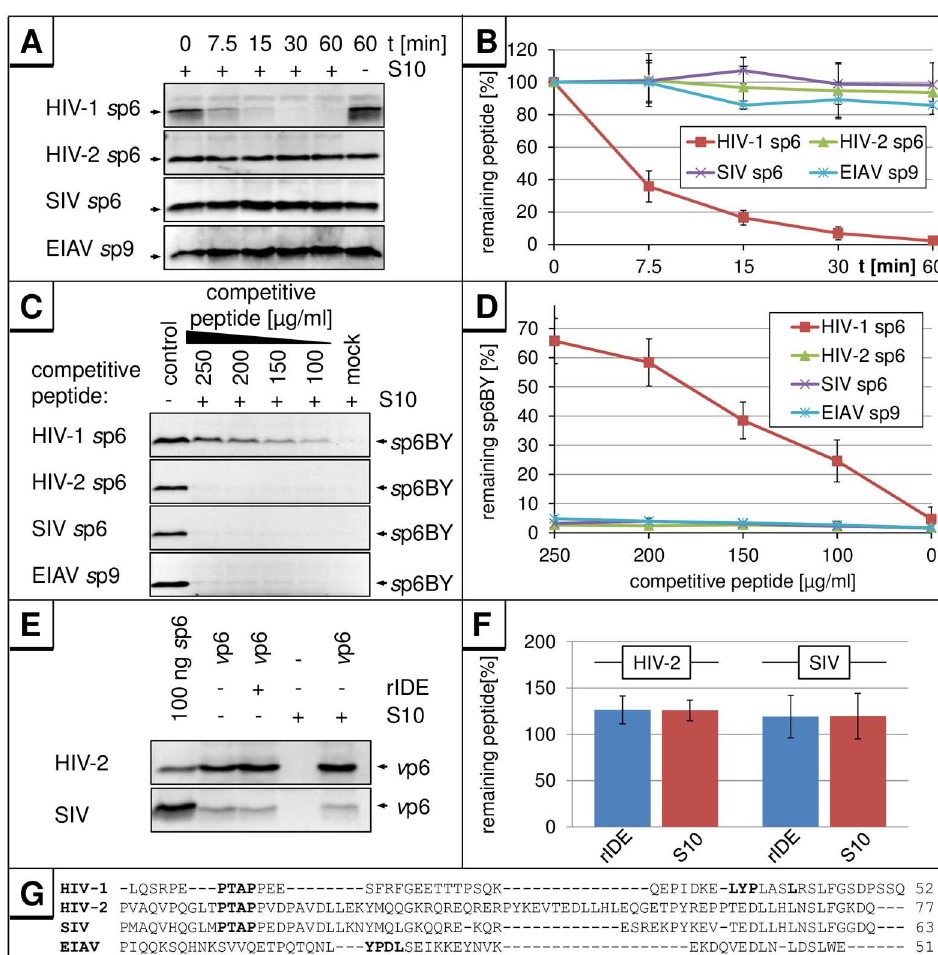
Fig 4. The 51 aa EIAV p9 protein and HIV-2 or SIV p6 are not degraded in S10. (A) 400 ng of HIV-2 or SIV s p6, or 100 ng of HIV-1 s p6, or EIAV s p9 were incubatedwith 5 μ g S10 extract for the indicatedtimes at 37˚C, and remaining s p6 or s p9 was detected by Western blot. (B) Band intensitieswere quantified for three independently performed experiments. Values representthe arithmetic mean ± SD. (C) 10 ng s p6BY were incubatedwith 5 μ g S10 and increasingconcentrations of HIV-1, HIV-2 or SIV s p6 or EIAV s p9 for 30 min at 37˚C. s p6BY was detected by measurement of fluorescence excitation. (D) Band intensitieswere quantified for three independently performed experiments. Values representthe arithmetic mean ± SD. (E) Virions produced in HEK293T cells transfected with expressionplasmidspNLgp2/Udel-1 (HIV-2) or pSIV3+ (SIV) were isolated, lysed with 0.5% Triton X-100 and incubatedwith 5 μ g S10 extract or 10 ng rIDE for 30 min at 37˚C. (F) Band intensitieswere quantified for three independently performed experiments. Valuesrepresent the arithmetic mean ± SD. (G) Sequence alignment of p6 peptides from HIV-1, HIV-2, SIV and the EIAV p9 peptide. The sequenceof HIV-2 p6 originatesfrom the isolate ROD10, SIV p6 from SIVmac239, and EIAV p9 from the isolate EIAV Wyoming